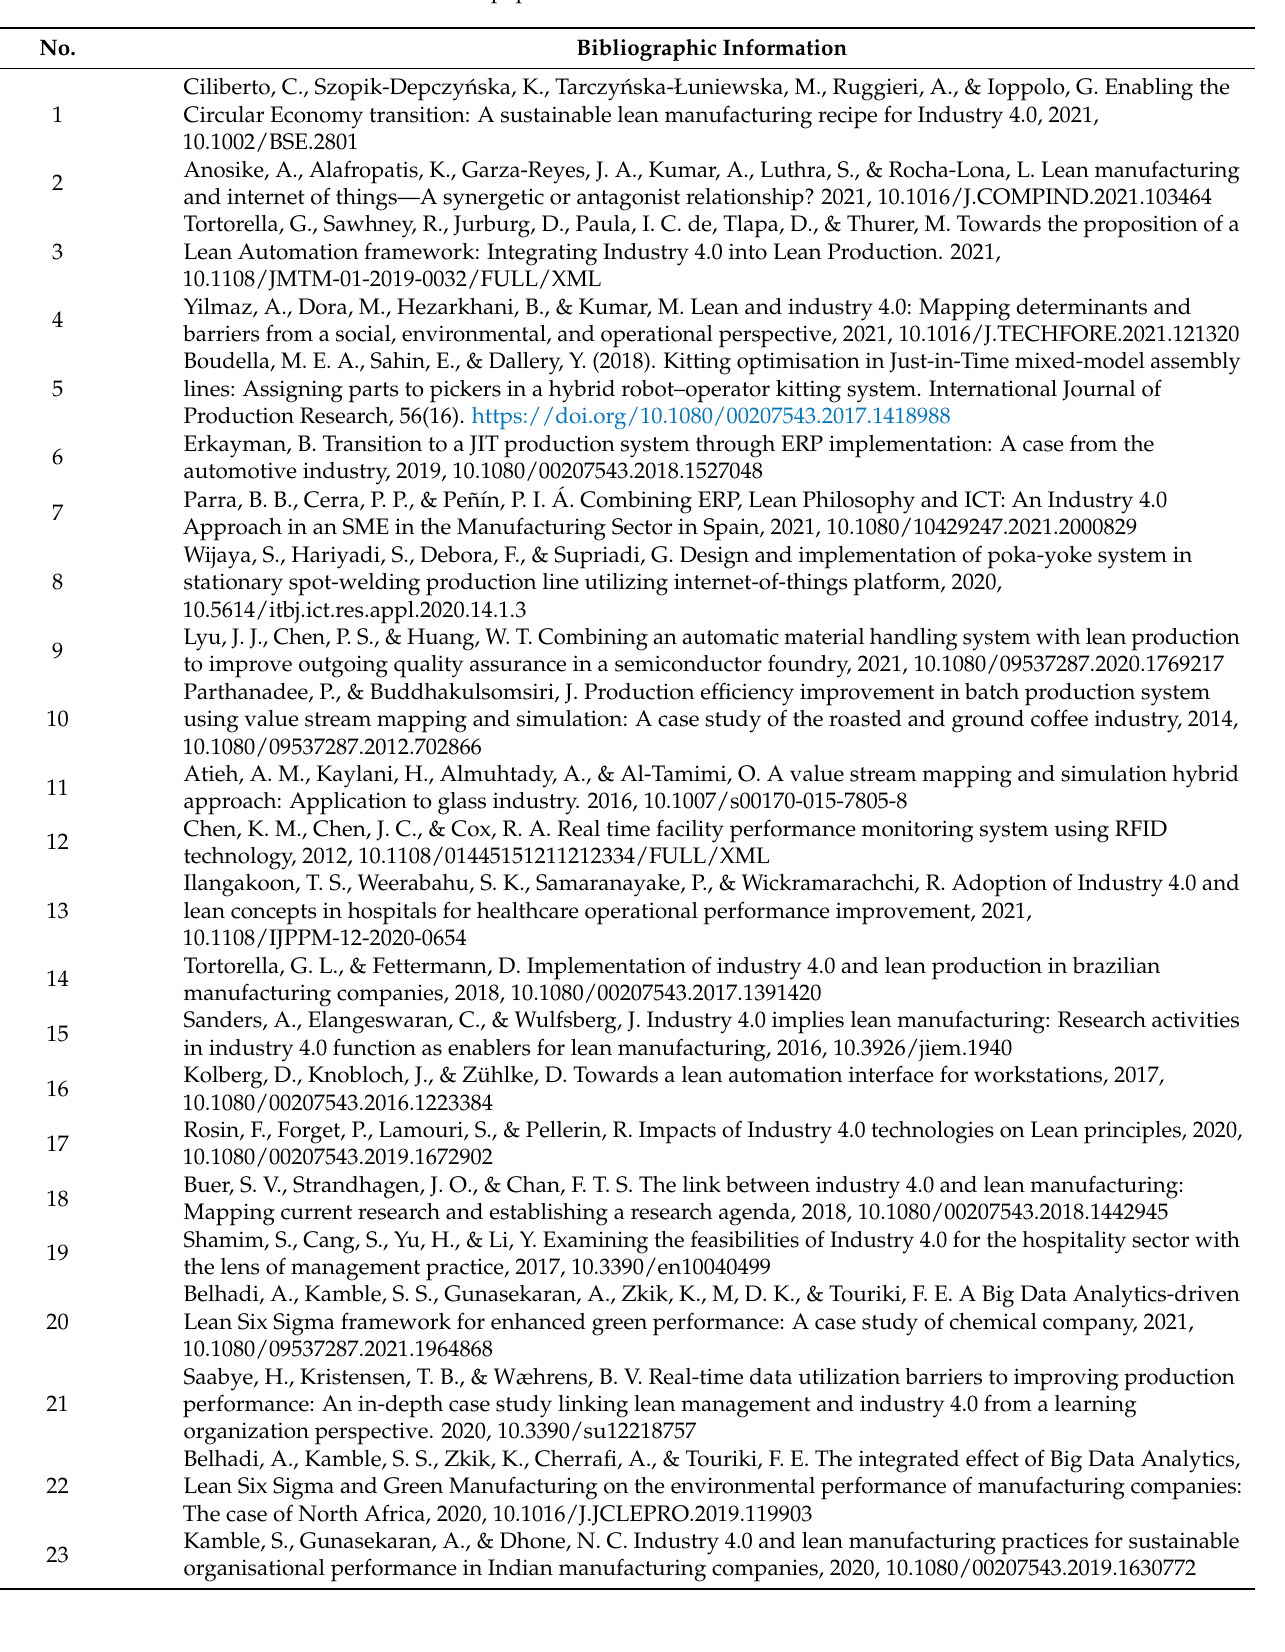
Table A1. Final list of papers included in the literature